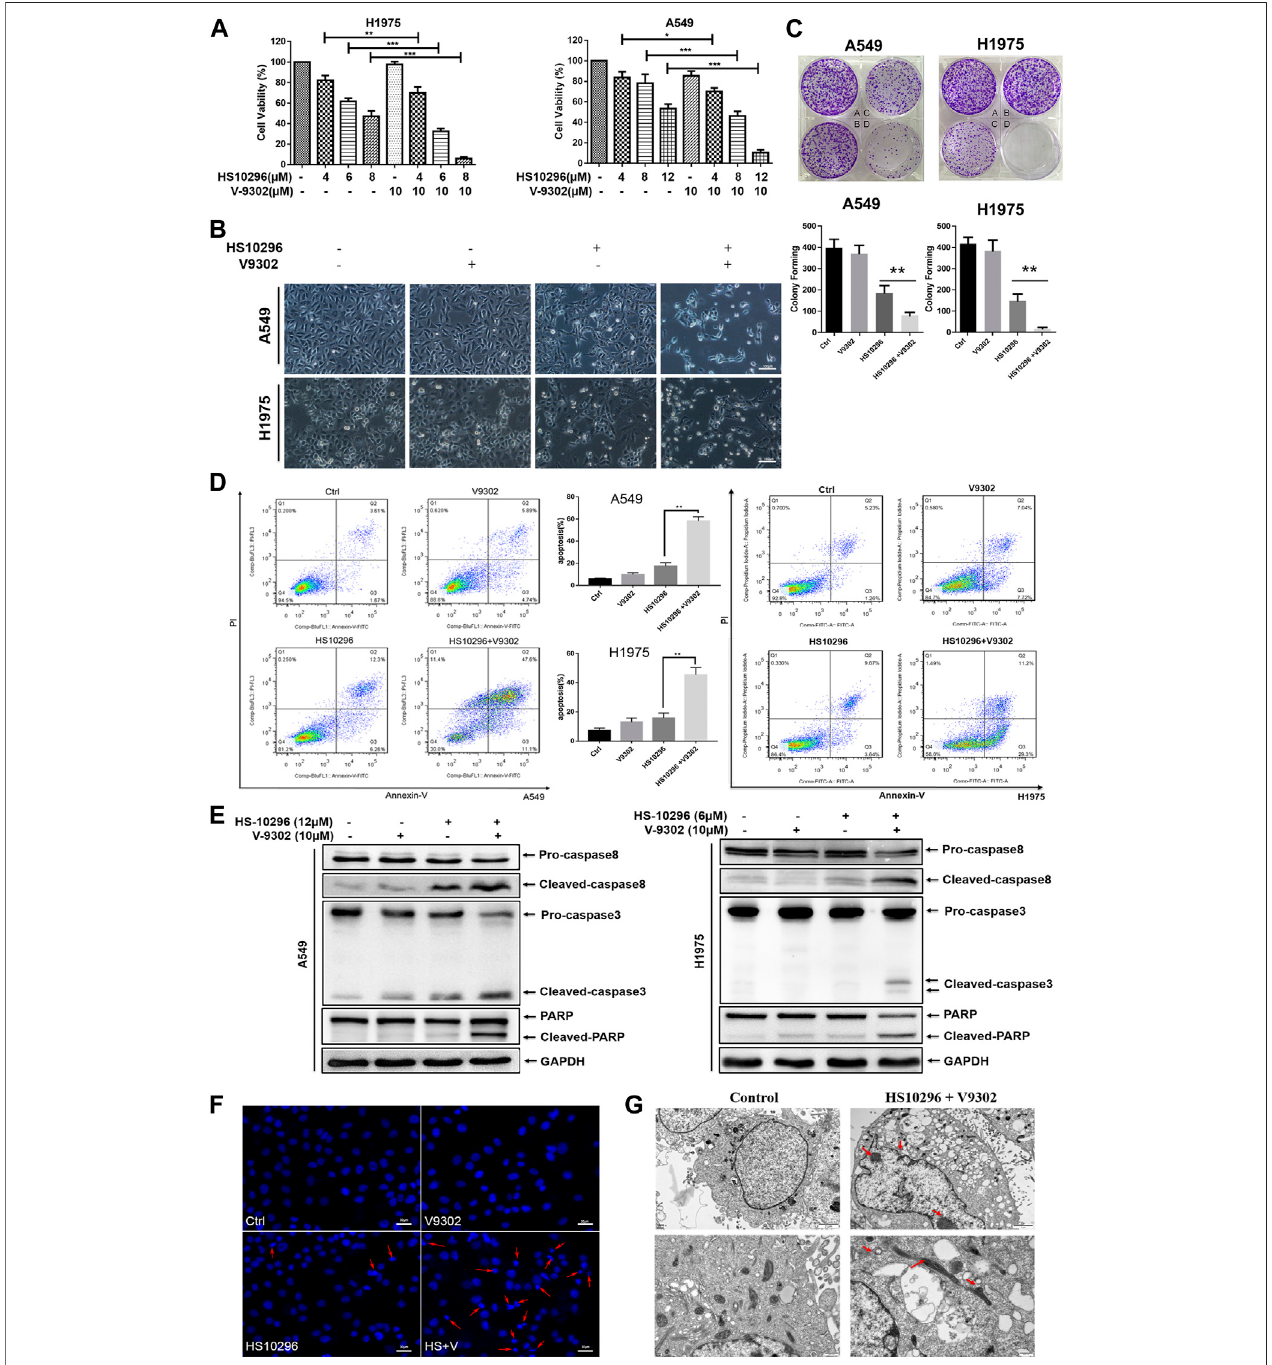
FIGURE 4 | V9302 enhanced the inhibitory effect of Almonertinib on the proliferation of NSCLC cells. (A) The effect of different concentrations of Almonertinib and 10 µM V9302 on cells alone or in combination was used for 24 h to test the effect of H1975 or A549 cell viability by CCK8. (B) Cell morphological changes observed under an inverted microscope after 12 μ M (or 6 μ M) Almonertinib and 10 μ M V9302 were used separately or in combination for 24 h. (C) Effects of Almonertinib and V9302 alone or in combination on the colony forming ability. A549 cells (A: blank group B: 1 µM V9302 C: 1.2 µM Almonertinib D: 1 µM V9302 and 1.2 µM Almonertinib);H1975cells(A:blankgroupB:1 µMV9302C:0.8 µMAlmonertinibD:1 µMV9302and0.8 µMAlmonertinib). (D) AftertheinterventionofAlmonertiniband V9302aloneorincombinationfor24 h,theapoptosisrateofA549cellswasdetectedbydoublestaining. (E) Proteinexpressionofcaspase8,caspase3andPARP.The effects of Almonertinib and V9302 alone or in combination on the expression of A549 or H1975 cells for 24 h were detected by WB. (F) DAPI fl uorescence staining was used to observe the nuclear changes of H1975 cells after Almonertinib and V9302 were treated alone or in combination for 24 h. (G) The submicroscopic structure of H1975 cells was observed by electron microscopy after treat with 6 µM Almonertinib combined with 10 µM V9302 for 12 h. Signi fi cance: * p < 0.05, ** p < 0.01.